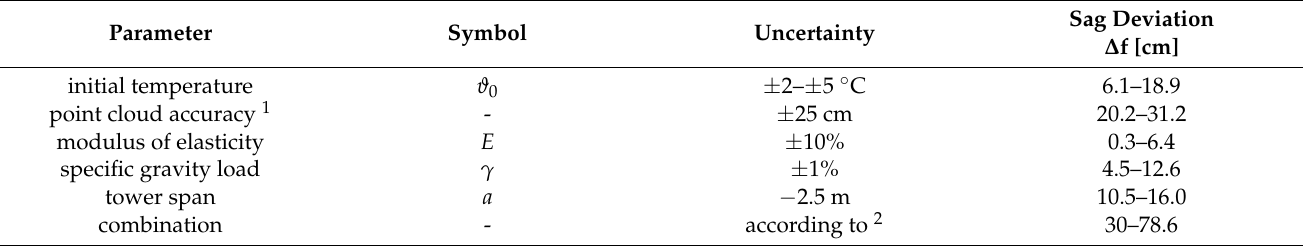
Table 10. Summary of results from Section